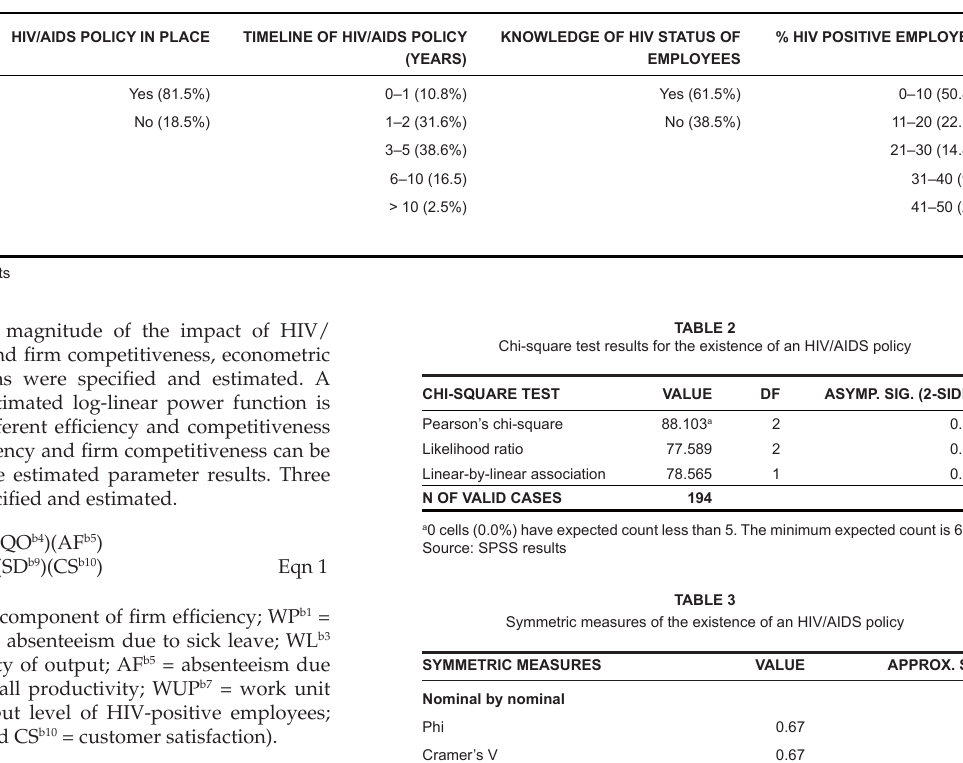
TABLE 1 Statistical results of Section A of the survey questionnaire